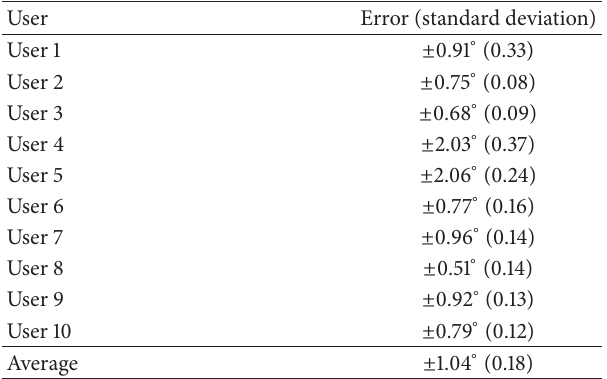
Table 2: Gaze estimation uncertainties in proposed